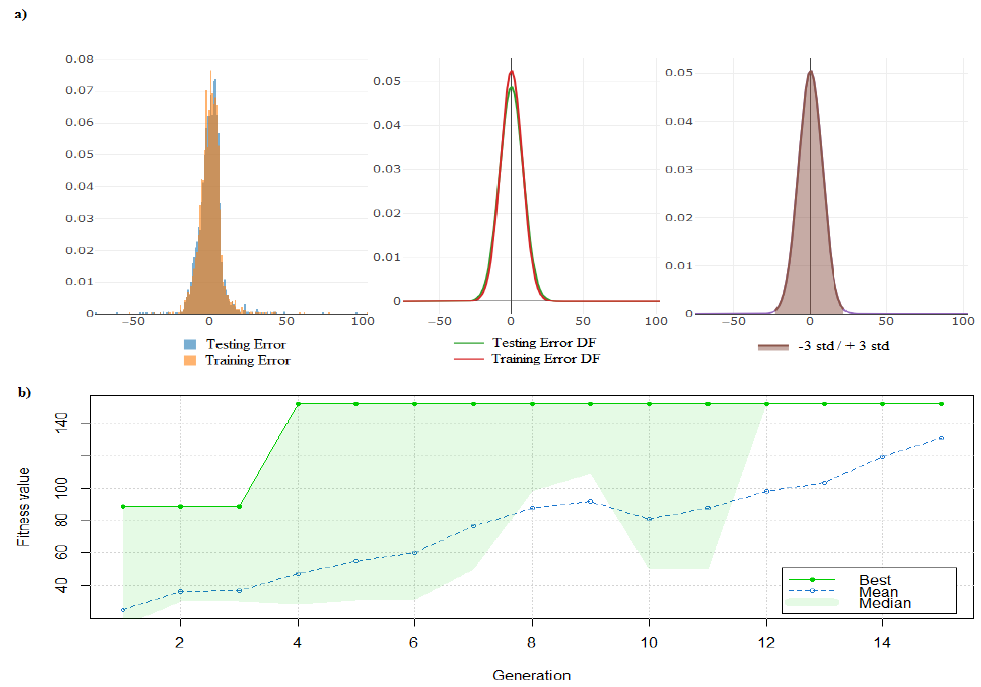
algorithm performance. Appl. Sci. 2019 , 9 FOR performance.